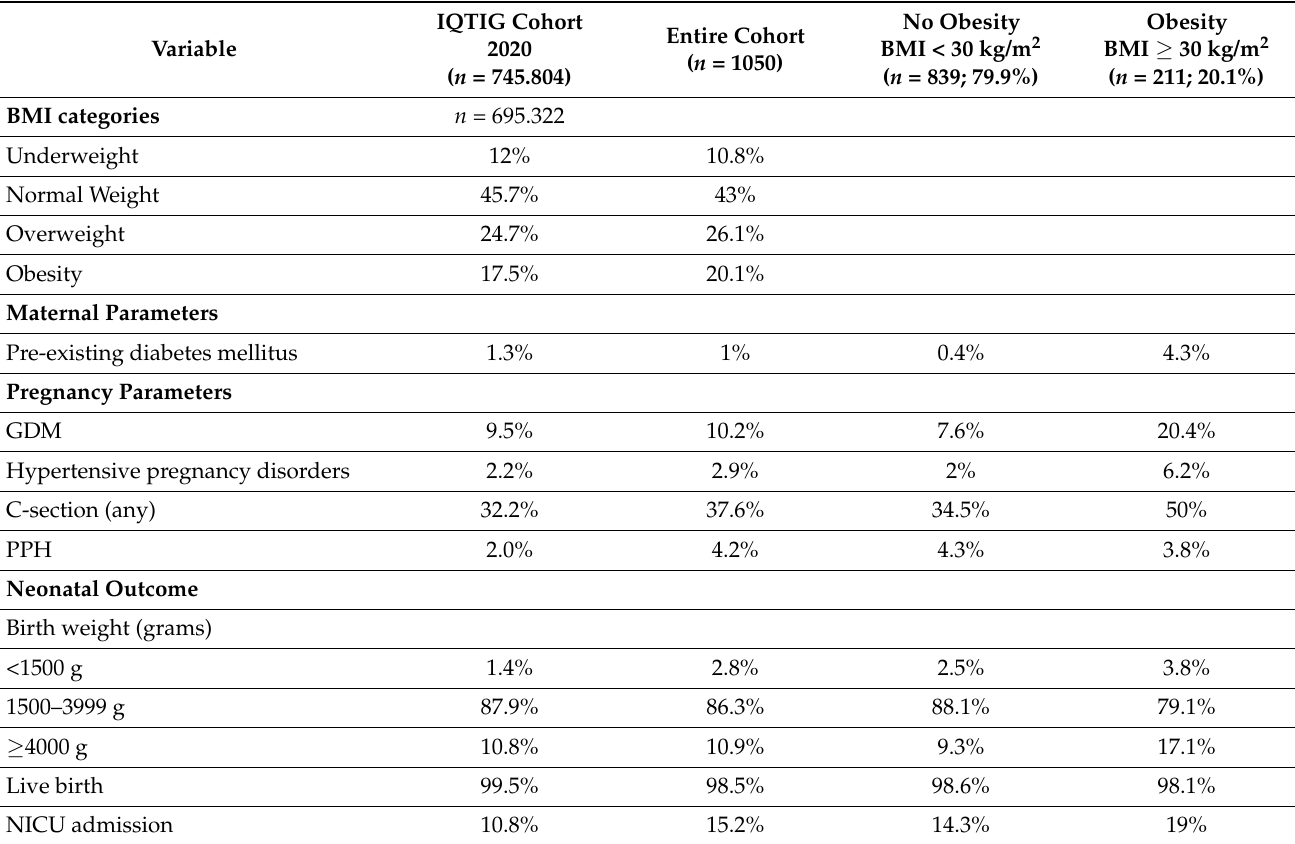
Table A1. Comparison of CRONOS cohort data with the German perinatal data